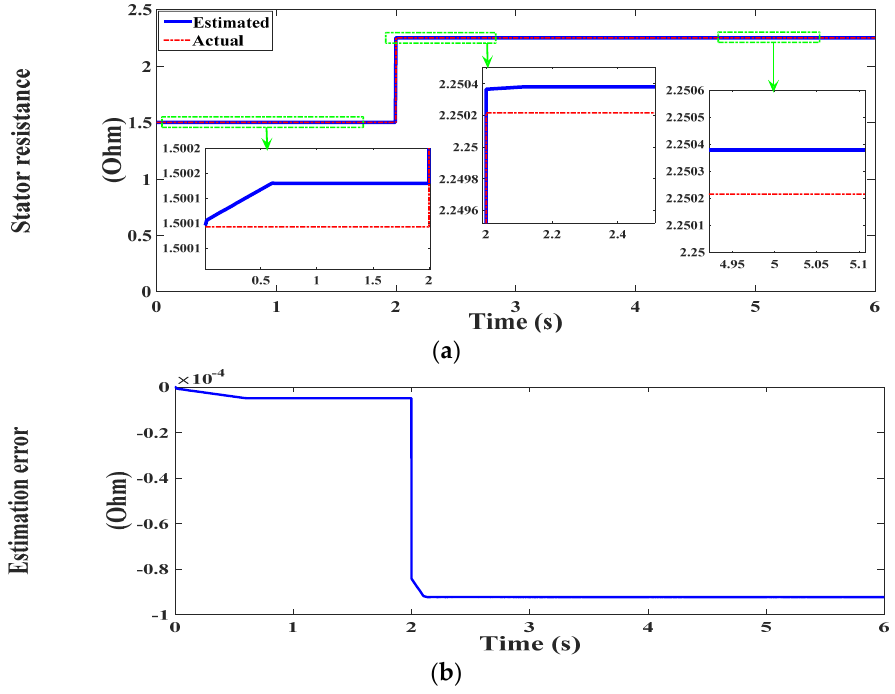
Figure 13. ( a ). Stator resistance variation under PTC ( Ω ), ( b ). Rs estimation error under PTC ( Ω ).